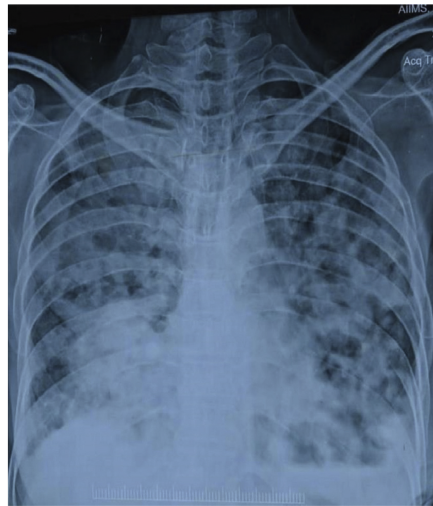
Figure 2: X-ray chest PA view shows bilateral diffuse consolidation and